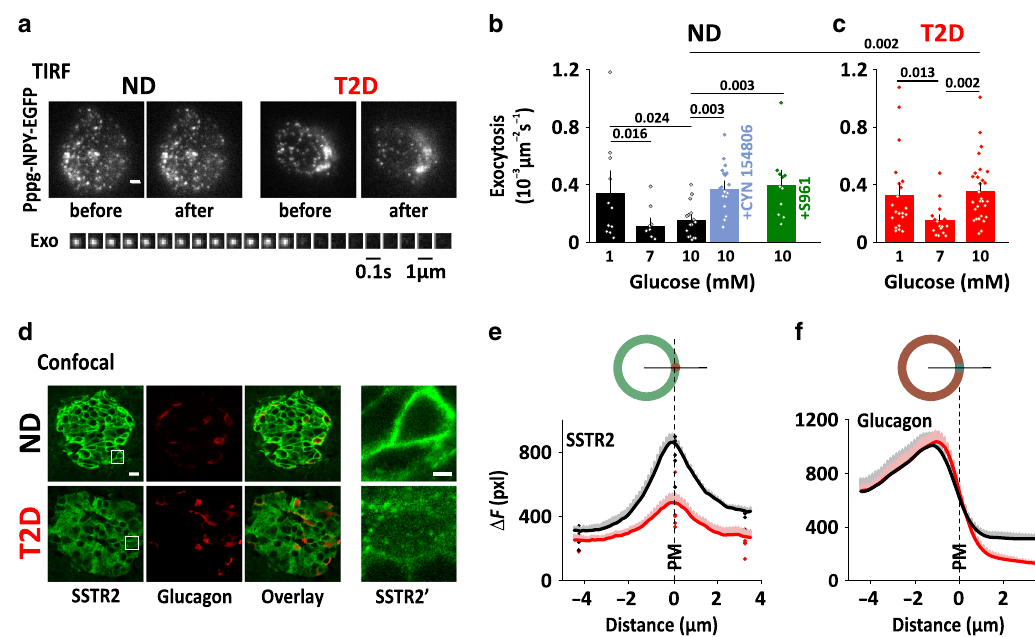
Fig. 4 Disturbed paracrine signaling in α -cells within intact islets. a TIRF images of NPY-EGFP of an α -cell within an intact islets of ND (left, representative for 67 cells) or T2D (right, representative for 66 cells) human donors. Scale bar 2 µ m. Lower: image sequence of an exocytosis event in the ND α -cell example. b Average spontaneous exocytosis in α -cells within intact ND islets that were bathed in 1 mM (11 cells/3 donors, black), 7 mM (10 cells/3 donors, black), or 10 mM glucose (16 cells/4 donors, black), and in 10 mM glucose with SSTR antagonist (200 nM CYN154806, 19 cells/3 donors, light blue) or insulin receptor antagonist (1 μ M S961, 11 cells/2 donors, green). Data are presented as mean values ± SEM. Scale bar 1 µ m. c As in b , but for α -cells within intact T2D islets at 1 mM (21 cells/5 donors), 7 mM (16 cells/4 donors), and 10 mM glucose (29 cells/5 donors). In b , c , p -values are indicated for selected comparisons (one-way ANOVA with Fisher posthoc test). Data are presented as mean values ± SEM. d Representative confocal images of human pancreatic tissue sections of ND donors (top) and T2D donors (bottom), co-immunostained anti-SSTR2 (green) and anti-glucagon (red); scale bar 10 µ m. The white square indicates the area that is enlarged in the right-most images (SSTR2; scale bar 2 µ m). e Average SSTR2 staining intensity (F-background, average pixel value pxl), measured along a line across the plasma membrane of 828 cells from 5 ND donors (black) and 824 cells from 5 T2D donors (red). Cells were spatially aligned so that the line crosses the center-right of the cell perimeter at distance zero (illustrated drawing, top). Dots indicate average donor values. Staining intensities at distance zero were signi fi cantly different between ND and T2d donors ( p = 4 × 10 − 11 , two-tailed t test). f As in b – e , but for glucagon